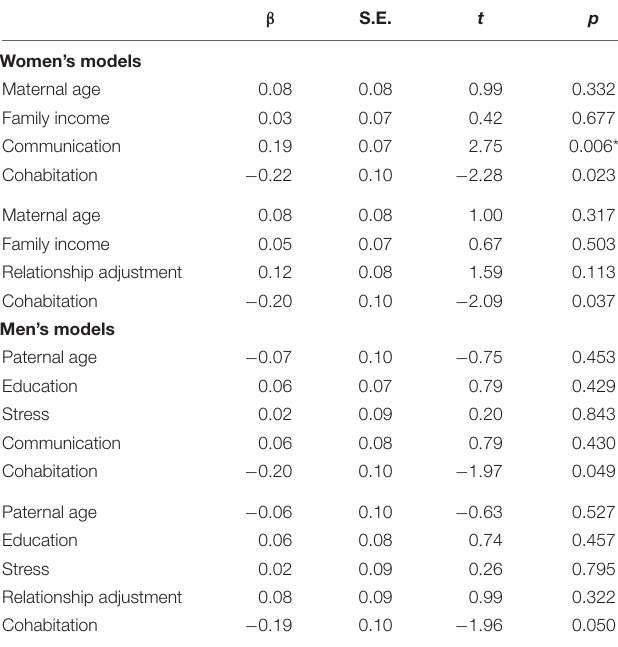
TABLE 1 | Baseline predictors of relationship stability (staying together) over the 10